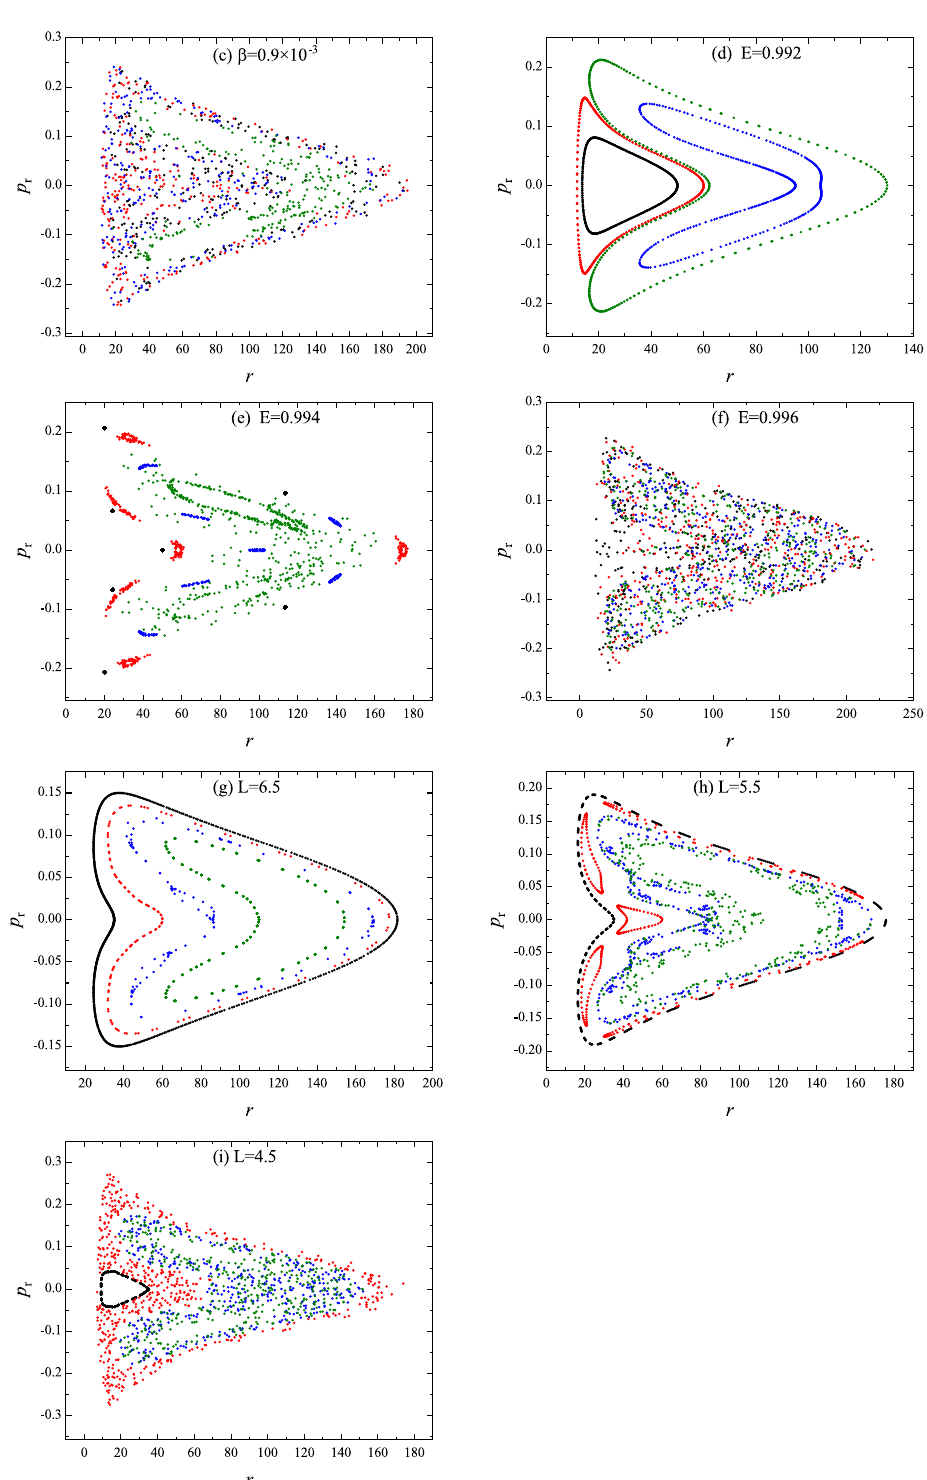
Figure 5. Poincaré sections. ( a – c ): Three different values are given to β . The modified gravity coupling parameter is α = 0.3, and the other parameters are consistent with those of Figure 4a. ( d – f ): Three different values are given to E . The modified gravity coupling parameter is α = 0.3, and the other parameters are those of Figure 4b. ( g – i ): Three different values are given to L . The modified gravity coupling parameter is α = 0.05, and the other parameters are those of Figure